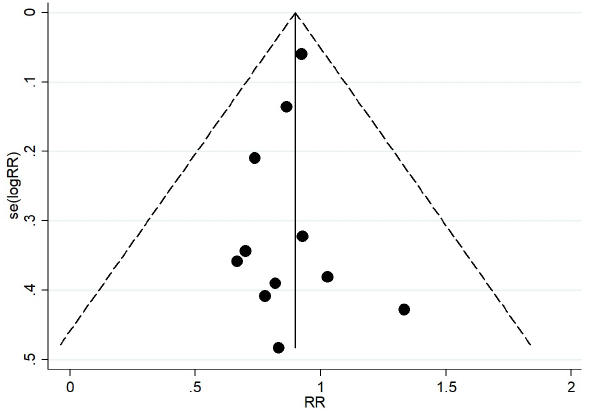
Figure 5: Begg’s funnel plot in evaluation the publication bias for the include 13